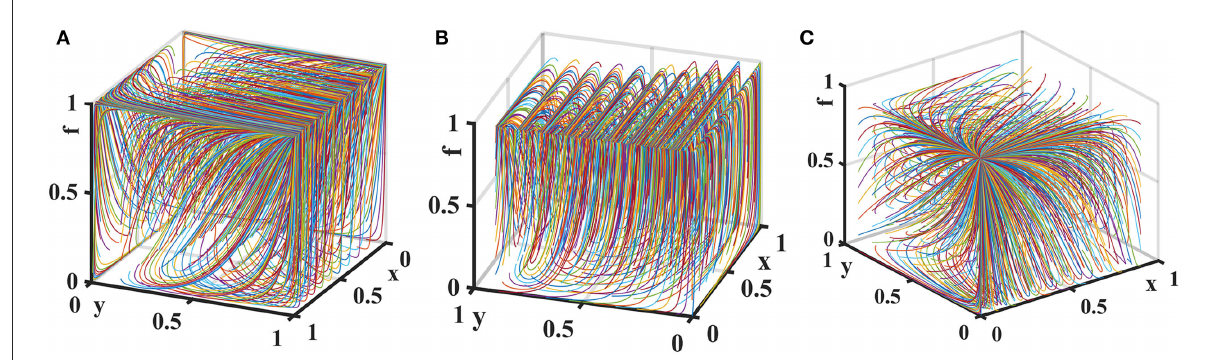
FIGURE8 Impact of additional costs on the evolution of each player’s strategy. Figure is the simulation diagram that shows the influence of the additional costs on the strategic choices of government regulator, pharmaceutical enterprises, and pharmaceutical e-commerce companies. (A)